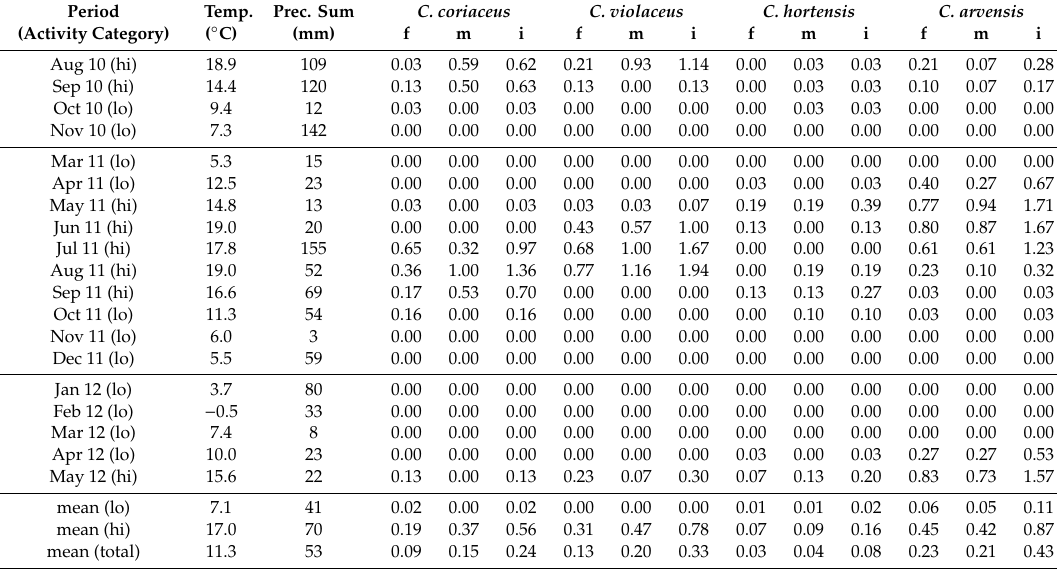
Table 1. Temperature ( ◦ C), precipitation (mm) and mean activity densities (m 2 per day) of the four chosen Carabid species ( C. arvensis , C. hortensis , C. violaceus , C. coriaceus ) separated by month for the sample periods 2010 to 2012 (activity: hi—period of high activity, lo—period of low activity, f—females, m—males,